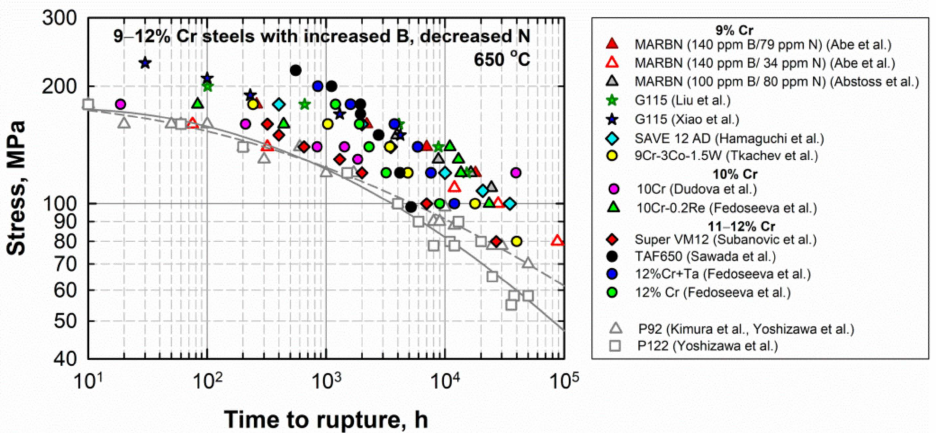
Figure 7. Timetorupturevs. stresscurvesof9–12%CrsteelswiththeincreasedBanddecreasedNcontents in comparison with the curves for the P92 and P122 steels. Data from [5,6,8,11,16,18,20,22,25,27,32,39].